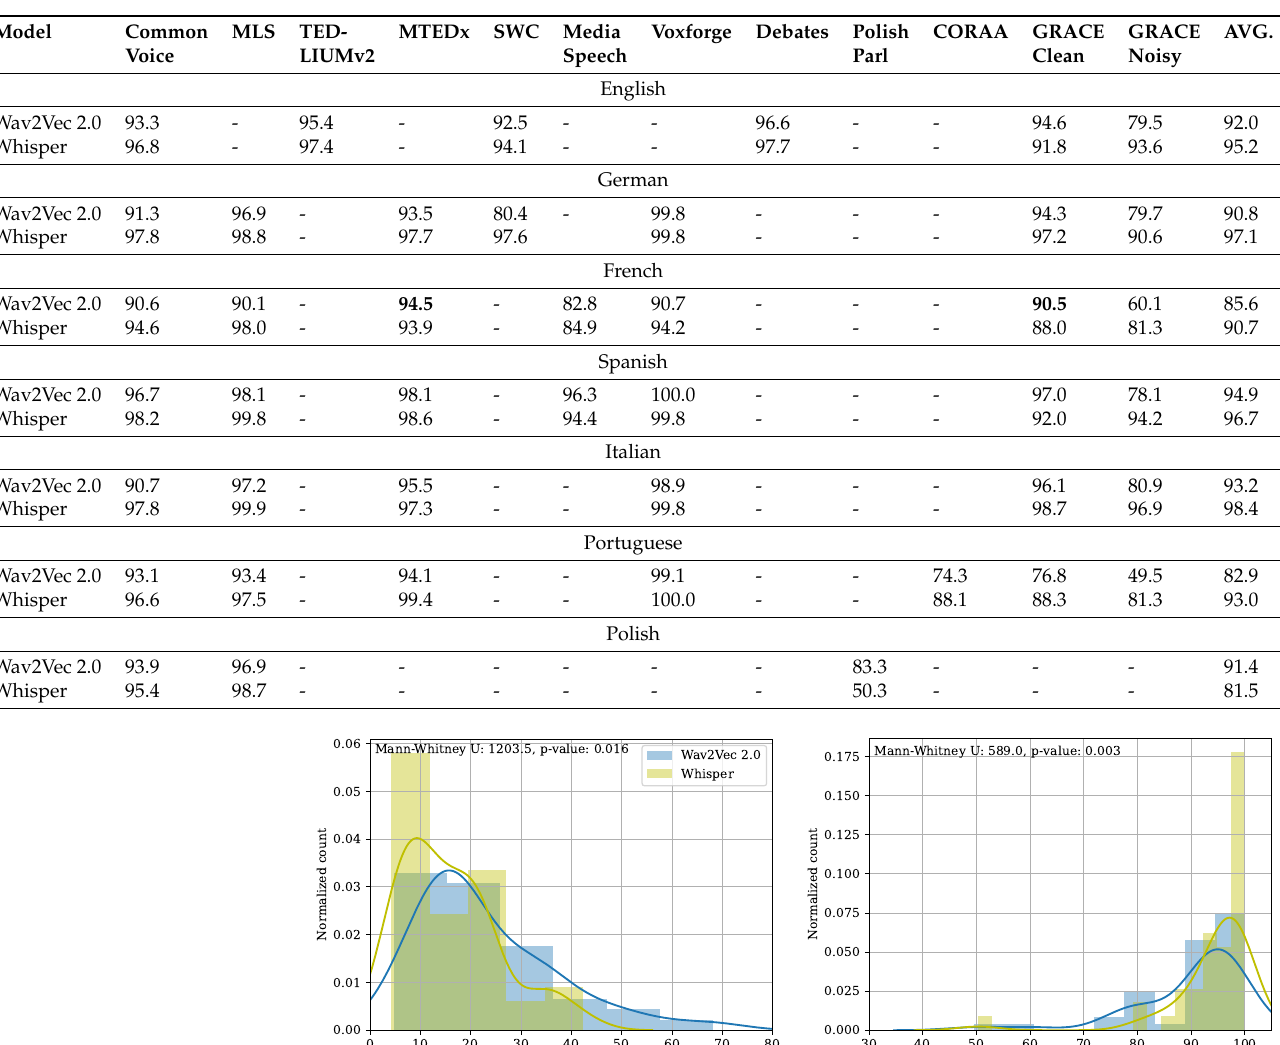
Table 5. Results of KWS in different languages considering all benchmark datasets. Results in terms of TPR (%).